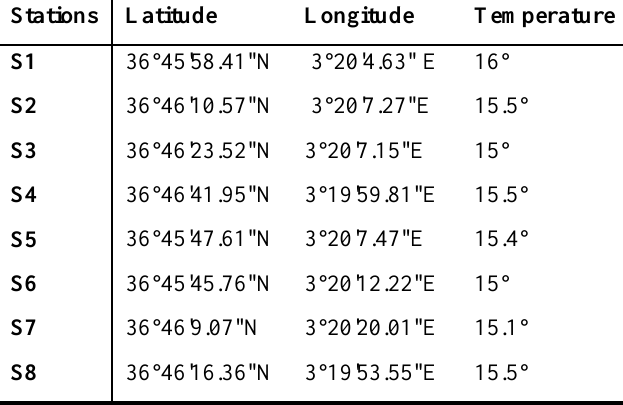
Table 1. The coordinates of the sampling